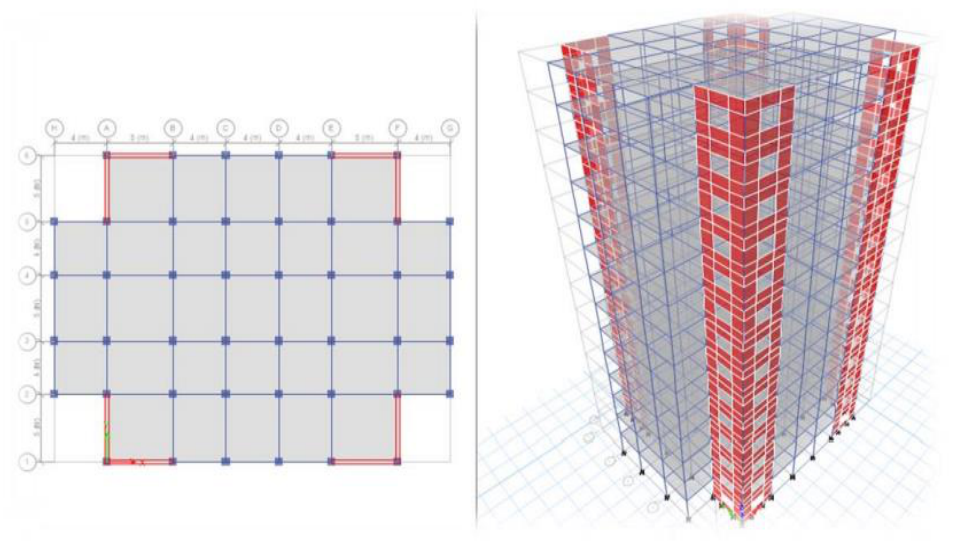
Figure 3. The geometry of the structure and 3D structure shear walls with vertical openings. Response spectrum function and time history function (El Centro 1940) have